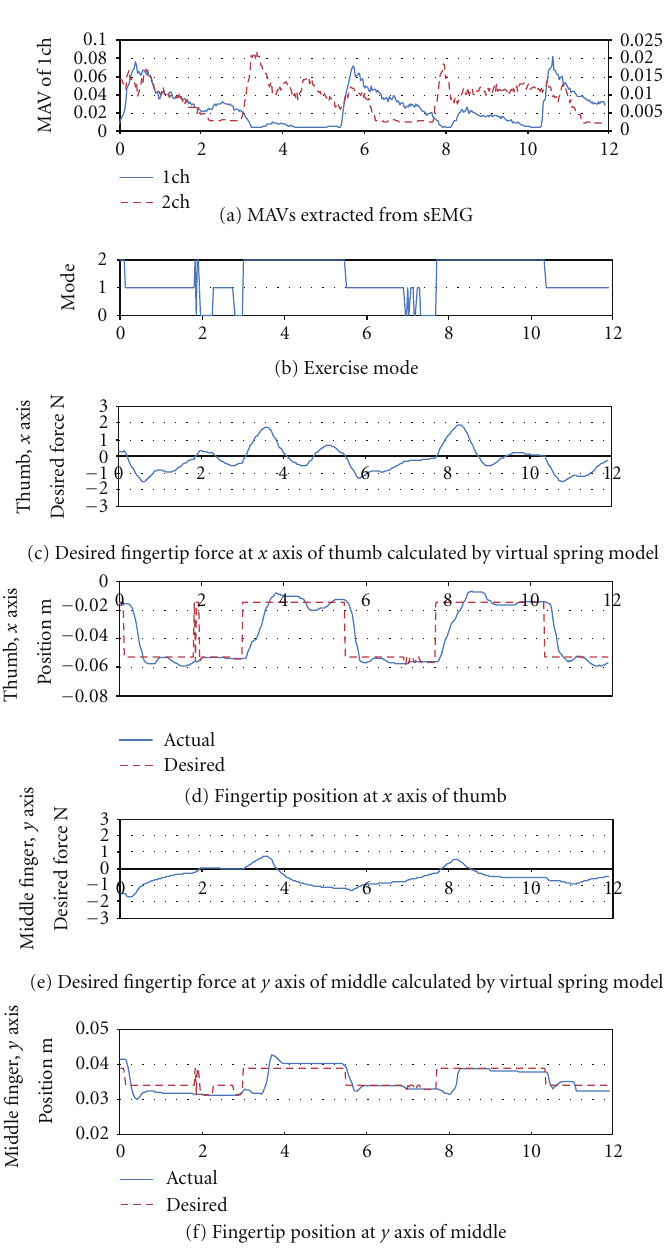
Figure 8: Example of the experiment. The horizontal axis of each subfigure shows the time history. Note that in the subfigure (a) the left side vertical axis shows MAV1 (MAV extracted from 1 ch sEMG) and the right shows MAV2. In this case, Thre1 is 0.024 and Thre2 is